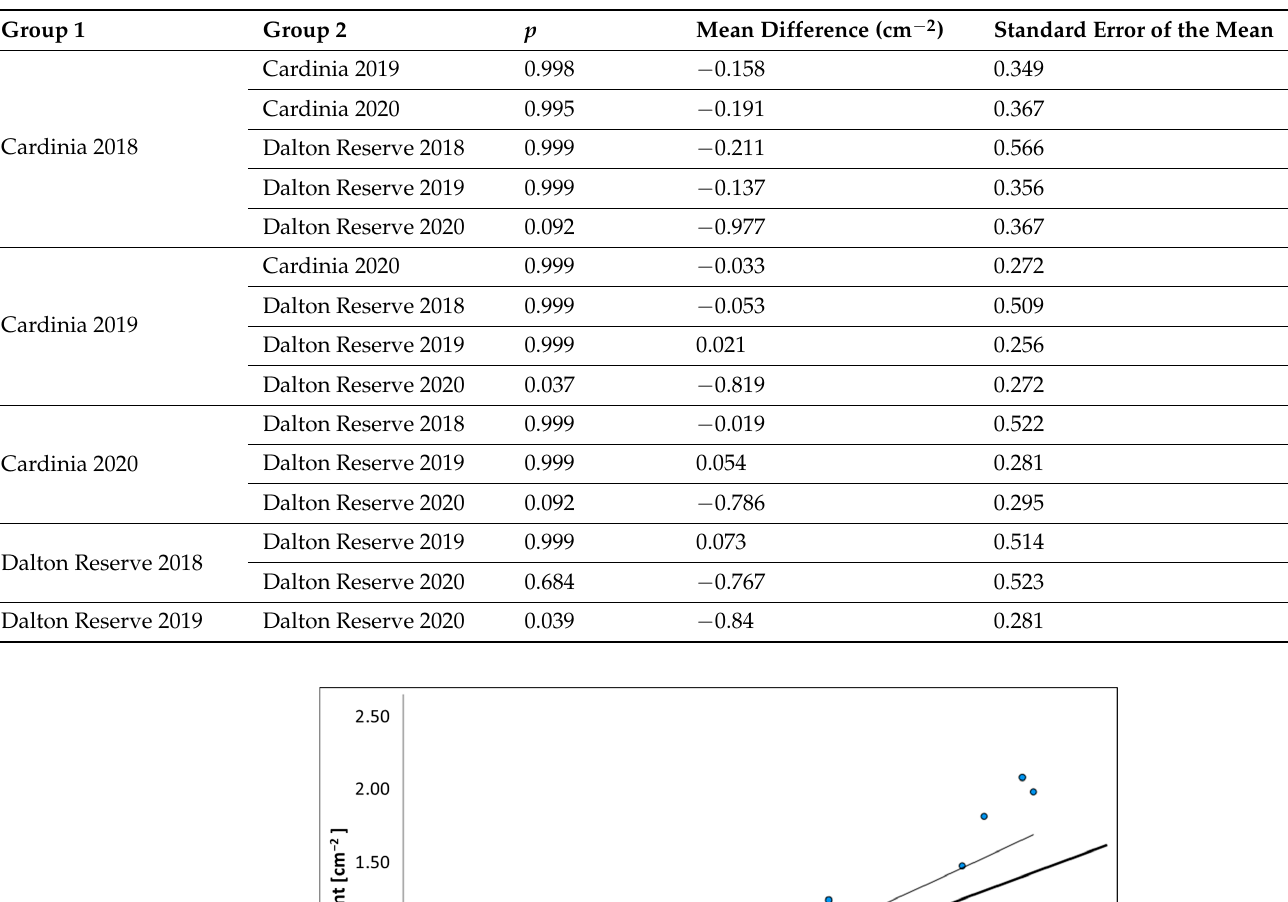
Table A5. Summary of Tukey’s HSD post-hoc testing differences in the density of Marchalina hellenica between site and generation groups.